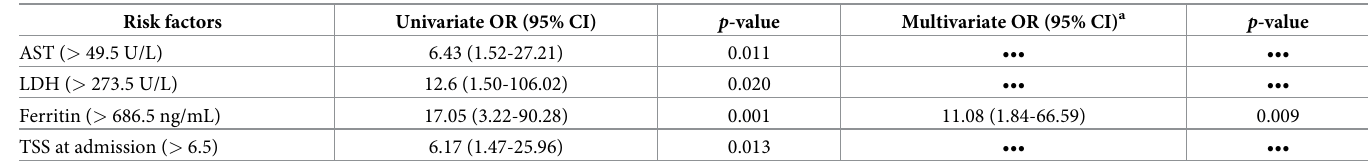
Table 4. Logistic regression analysis of risk factors for DLCO